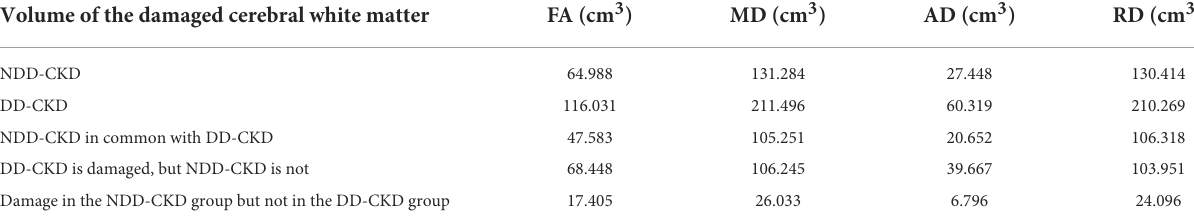
TABLE 6 Differences in the damaged white matter volume (cm 3 ) between the NDD-CKD and DD-CKD groups. Volume of the damaged cerebral white matter